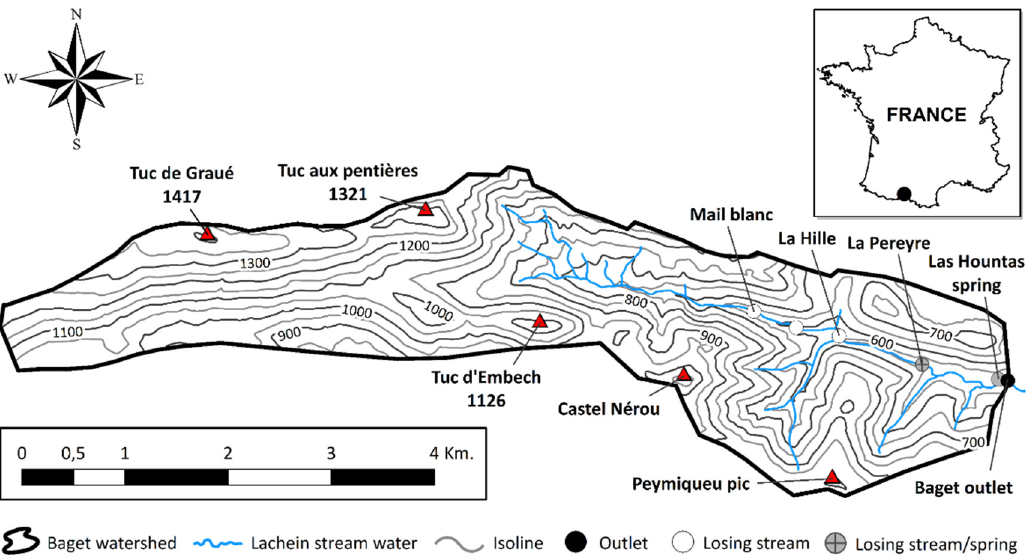
Figure 1. Location and relief of the Baget catchment with contour lines (modified from Ulloa-Cedamanos et al. [15]).